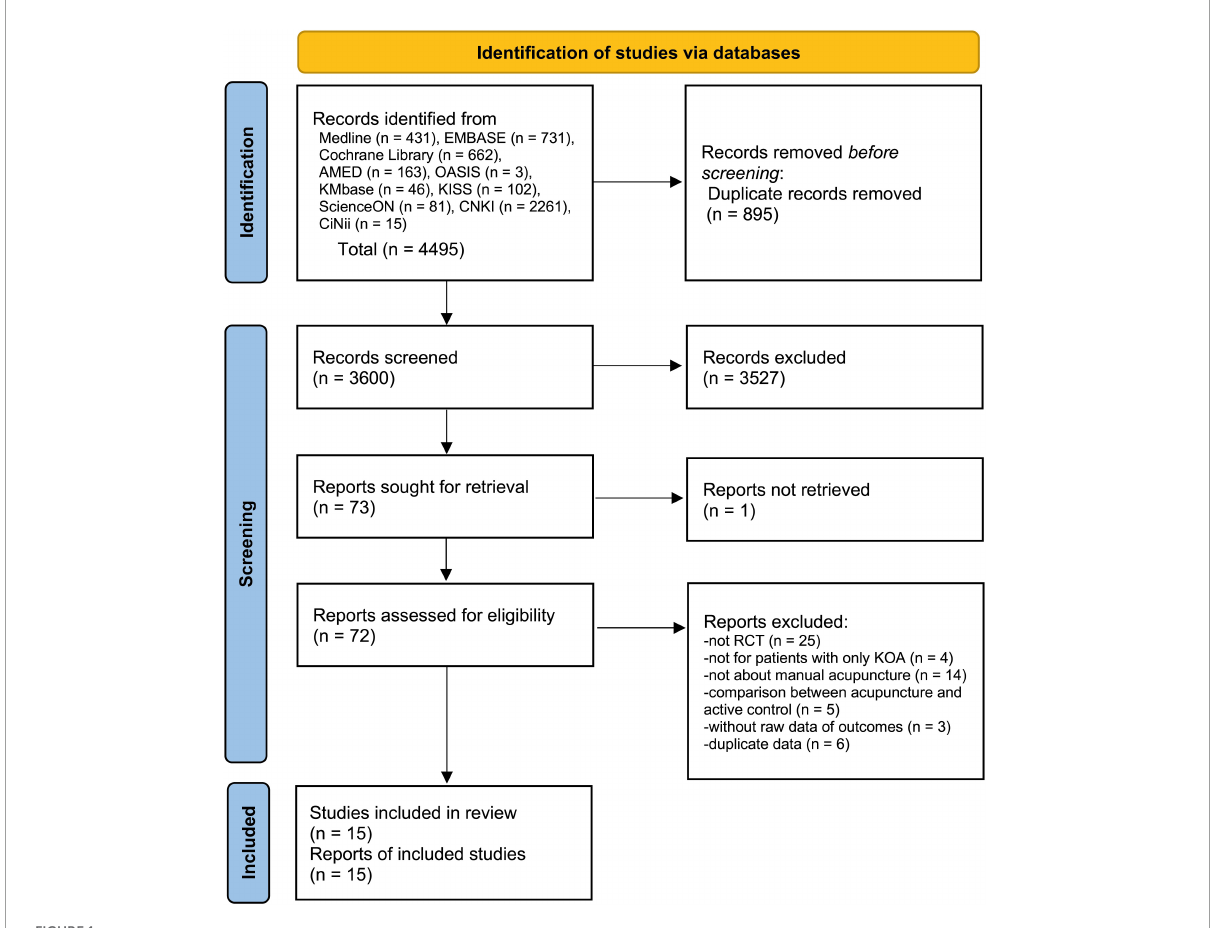
FIGURE1 A PRISMA flow diagram of the literature screening and selection